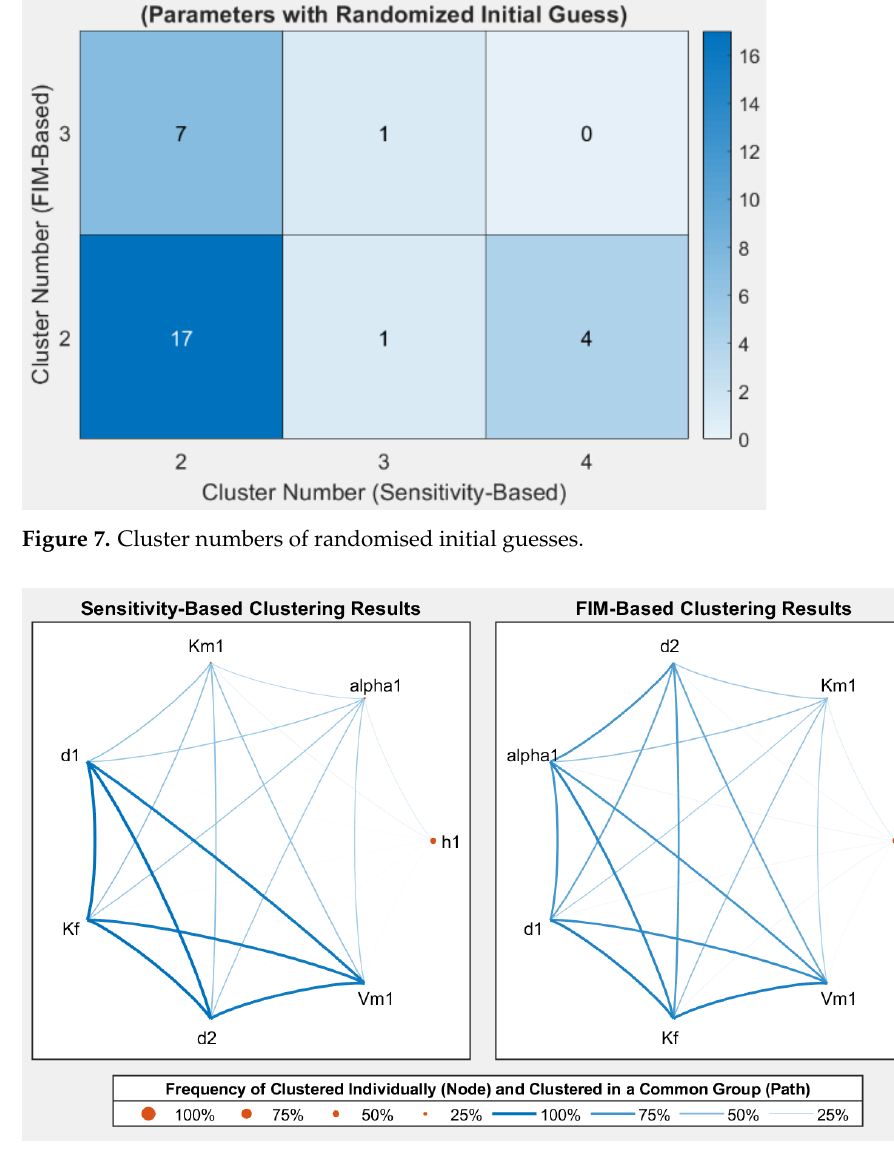
Figure 8. Visualisation of the clustering results with randomised parameter value